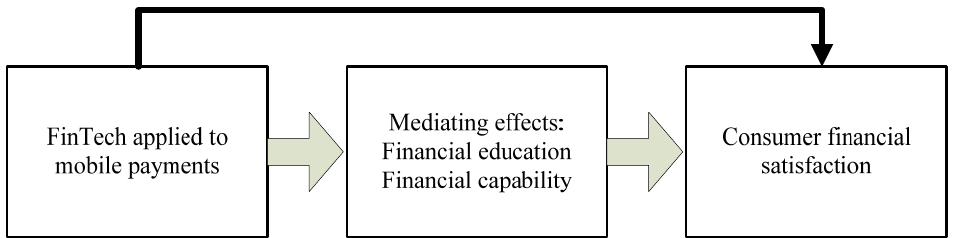
Figure 1. The conceptual